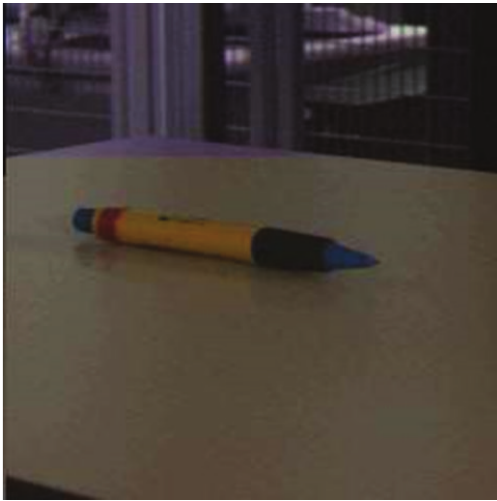
Figure 8: Pen at 𝜃 = 10 ∘ and 𝜙 = 54 ∘